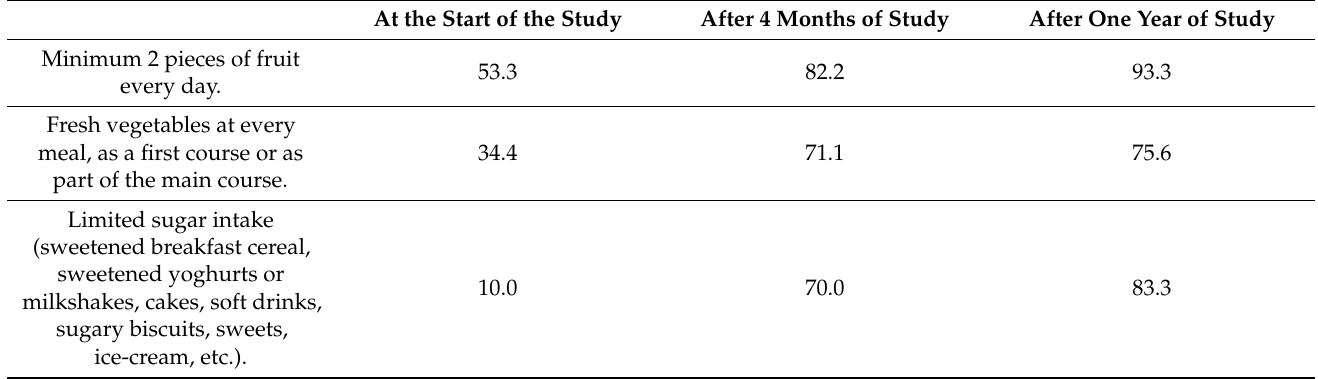
Table 8. TMD Test